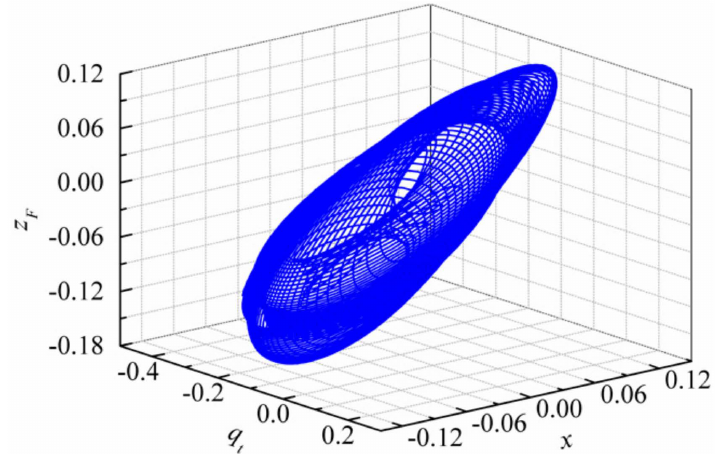
Figure 36. Phase space trajectory of variable responses in an HTGS with a downstream surge tank and an SCTT. Reproduced with permission from [52], Elsevier,